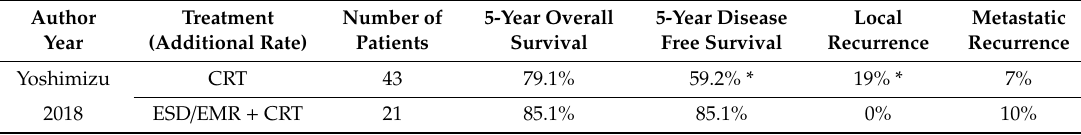
Table 5. Endoscopic resection and chemoradiotherapy (CRT) for esophageal squamous cell carcinoma with submucosal